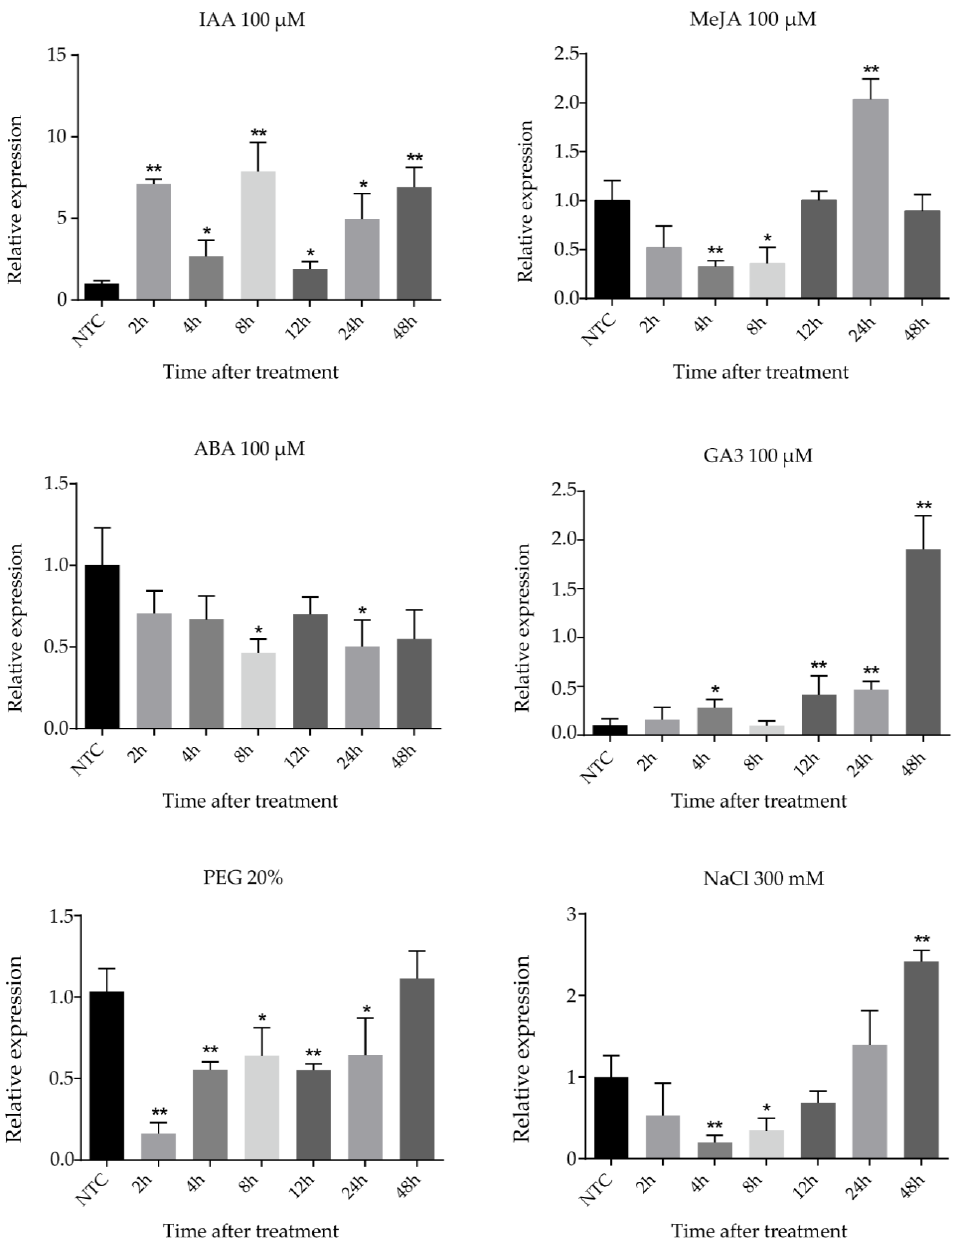
Figure 7. Expression profiles of FtsZ2-1 gene in response to various stress treatments. Data were normalized to the tubulin gene and vertical bars indicate standard deviation. Asterisk (* significant and ** highly significant) denote significant variation ( p < 0.05).